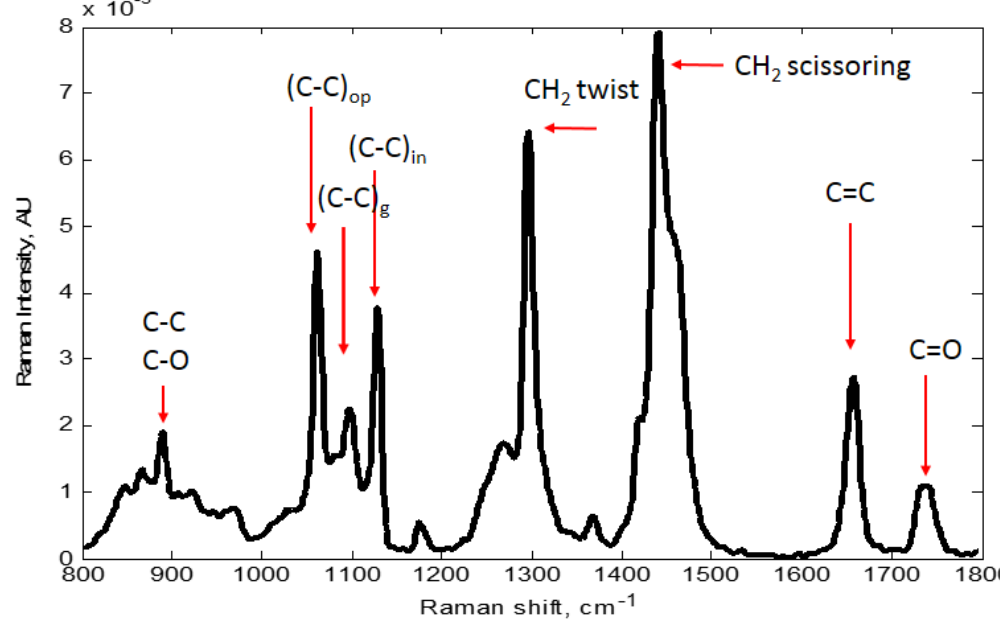
Fig. 2 Typical Raman spectrum of pork fat (IV =